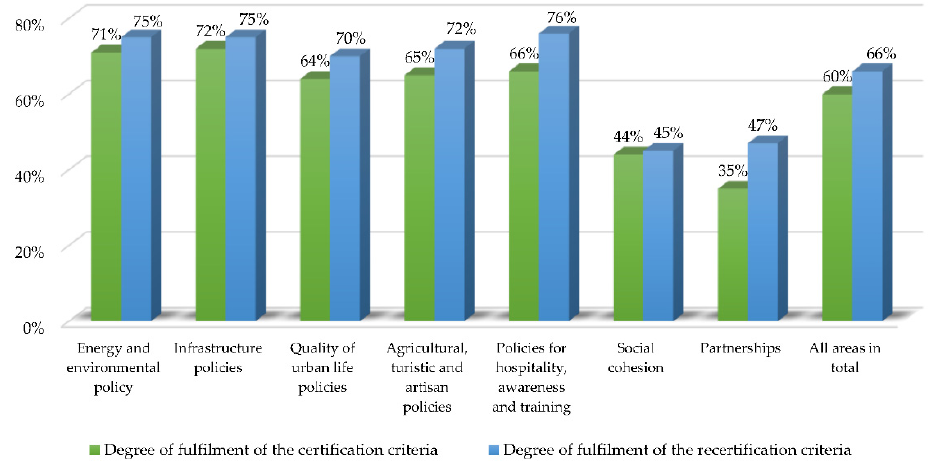
Figure 1. Degree of the fulfilment of certification and recertification criteria by the Polish slow cities. Source: own research based on certification and recertification forms, made available by the Cittaslow Office.